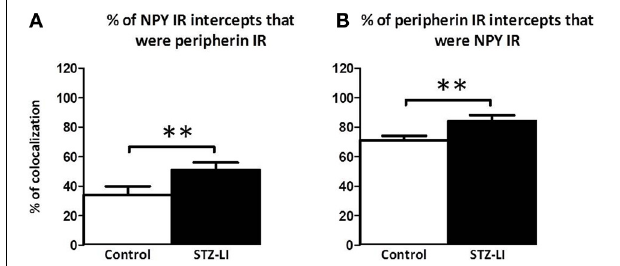
FIGURE 7 | Percentage of nerve fibers that were co-labeled for peripherin and neuropeptide Y (NPY) in the perivascular nerve plexus of plantar metatarsal arteries (PMAs) from control rats ( n = 8) and streptozotocin (STZ)-treated rats that received a low dose of insulin (STZ-LI, n = 8). In comparison with PMAs from control rats, those from STZ-LI rats had an increase in the number of NPY-immunoreactive (IR) intercepts along the line profiles that were peripherin-IR (A) and vice versa (B) . The data are presented as mean and s.e.m. Statistical comparisons were made with unpaired t -tests ( ∗∗ P < 0 .